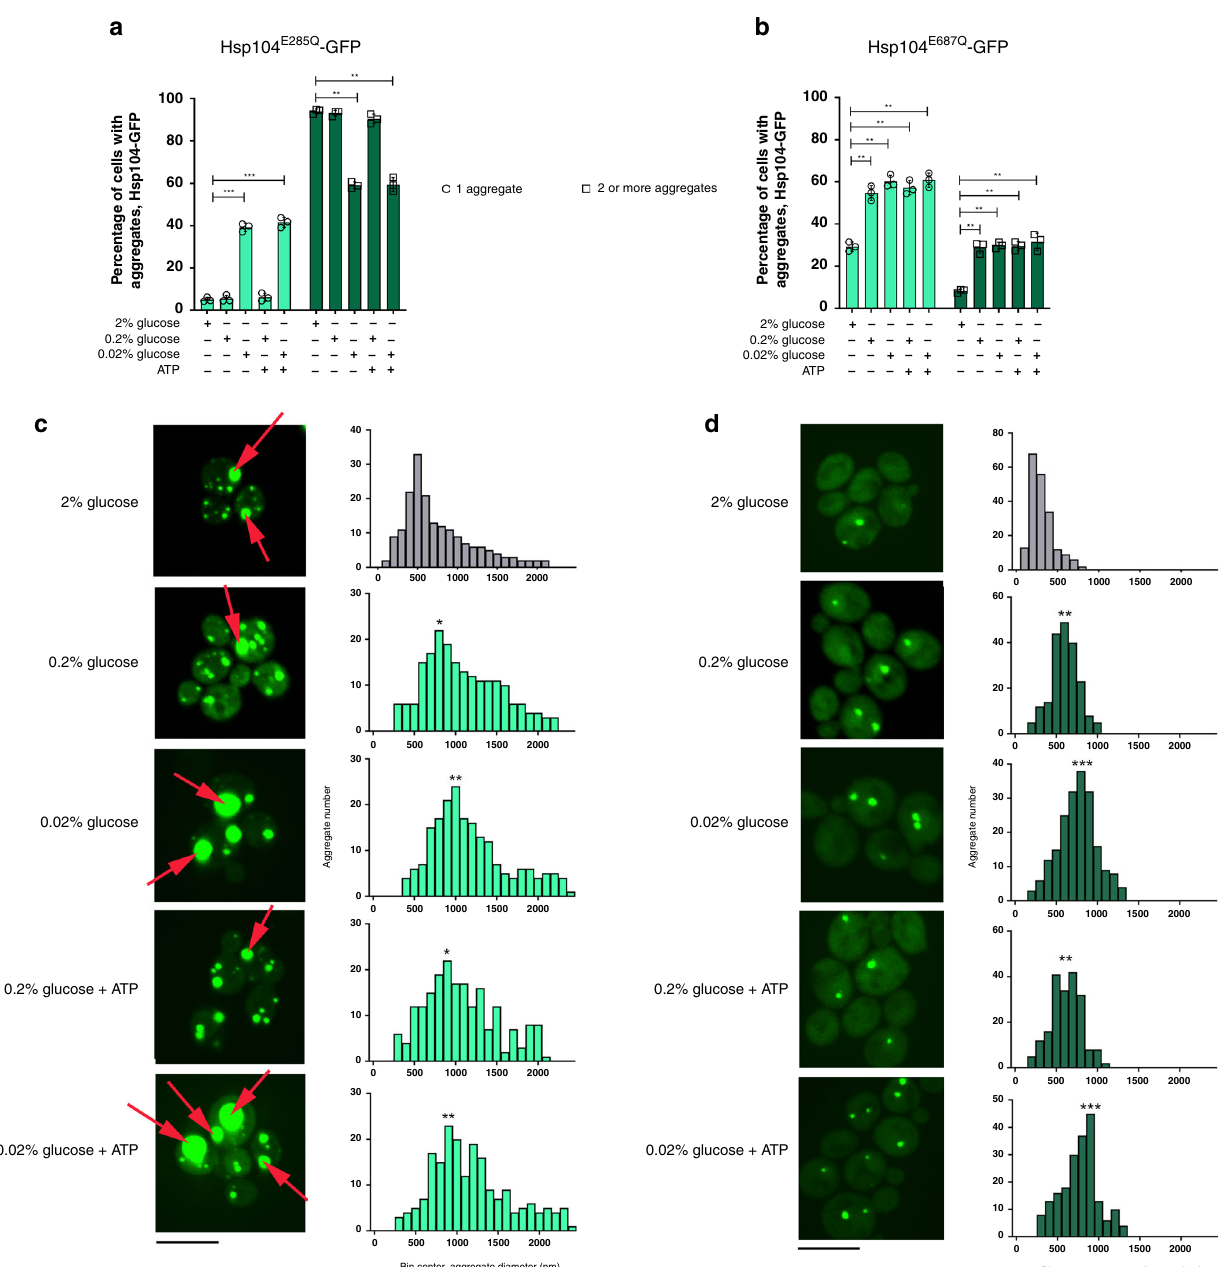
Fig. 2 ATP hydrolysis by Hsp104 counteract starvation-induced protein aggregation. a In cells expressing Hsp104 E285Q mutant, percentage of cells bearing aggregates is strongly increased in optimal conditions of 2% glucose and increases further in 0.2% and 0.02% glucose. Treatment with ATP (in the presence of DMSO) does not lead to aggregate dissolution. b In cells expressing Hsp104 E687Q mutant, percentage of cells bearing aggregates is increased in optimal conditions of 2% glucose and increases further in 0.2% and 0.02% glucose medium. Treatment with ATP (in the presence of DMSO) does not lead to aggregate dissolution. In panels a and b , n = 1200 cells were screened for aggregates starting from three independent exponential yeast cultures for each condition. Data are mean ± SD from at least three independent cultures, each performed in triplicate, and the means of technical replicates are represented as individual data points. *** p < 0.001; ** p < 0.01; * p < 0.05 (one-way ANOVA plus Tukey post hoc). d Mean aggregate diameter shifts to larger sizes during starvation in 0.2% and 0.02% glucose in Hsp104 E285Q mutant. The addition of ATP (in the presence of DMSO) did not result in aggregates reverting to the sizes observed in control conditions. Red arrows point to vacuolar localization of the signal and represent structures that were not taken into account during image analysis. Data represent binned values of individual aggregate diameters for N = 185, 200, 199, 200, 200 aggregates from three independent exponential yeast cultures for each condition: 2%, 0.2%, and 0.02% glucose, 0.2% glucose + ATP, 0.02% glucose + ATP, respectively. Mean aggregate diameter shifts to larger sizes during starvation in 0.2% and 0.02% glucose in Hsp104 E687Q mutant. The addition of ATP (in the presence of DMSO) did not result in aggregates reverting to the sizes observed in control conditions. Data represent binned values of individual aggregate diameters for N = 200 aggregates from three independent exponential yeast cultures for each condition. In panels c and d , Kolmogorov – Smirnov test was used to compare the statistical signi fi cance of the observed differences between each studied condition and the control (2% glucose) (*** p < 0.001; ** p < 0.01; * p < 0.05). The images are representative of three biological replicates, each in three technical replicates. The black bar represents 8 µ